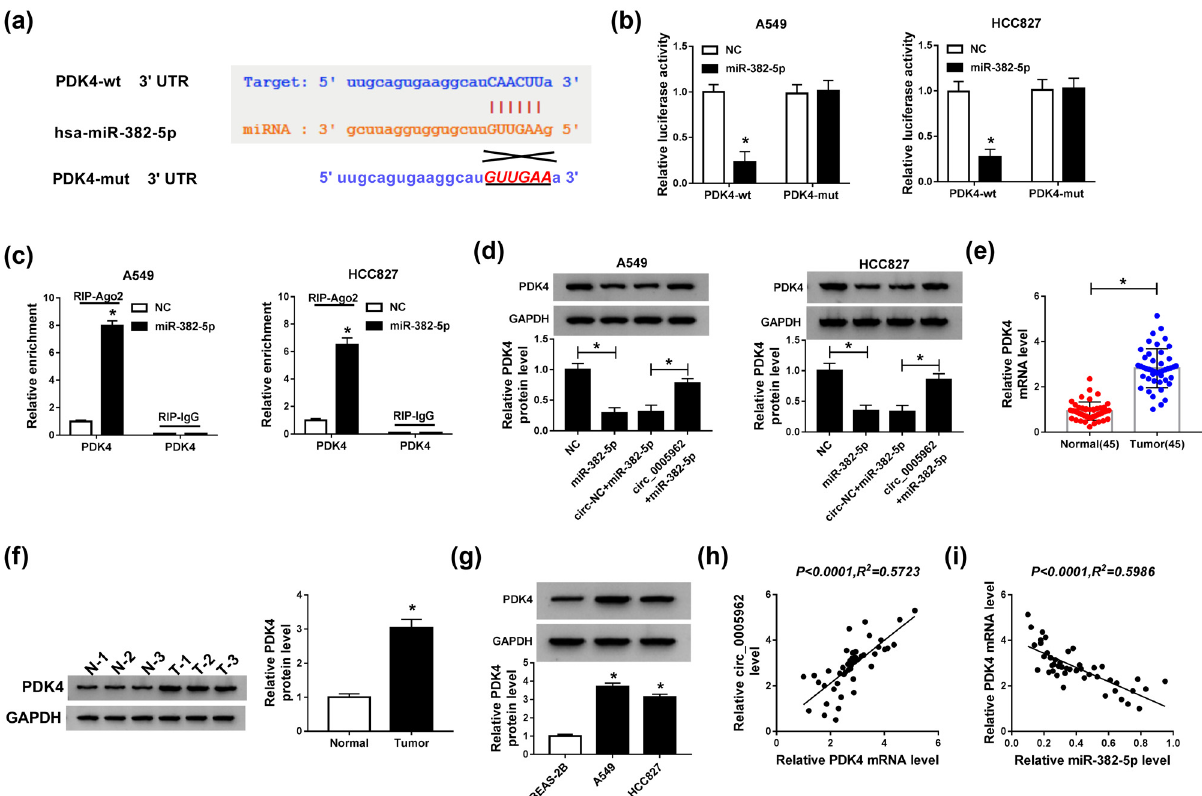
Figure 5: PDK4 was a target of miR - 382 - 5p. ( a ) The binding sites between PDK4 3 ′ UTR and miR - 382 - 5p were analyzed by online tool starbase. ( b ) The relationship between PDK4 and miR - 382 - 5p was veri fi ed by dual - luciferase reporter assay. ( c ) The relationship between PDK4 and miR - 382 - 5p was further con fi rmed by RIP assay. ( d ) The expression of PDK4 at the protein level in A549 and HCC827 cells transfected with miR - 382 - 5p or circ_0005962 + miR - 382 - 5p was detected by western blot. ( e and f ) The expression of PDK4 at mRNA and protein levels in NSCLC tissues was detected by qPCR and western blot. ( g ) The protein level of PDK4 in NSCLC cell lines was detected by western blot. ( h and i ) The correlation between PDK4 and circ_0005962 or miR - 382 - 5p was analyzed by Spearman ’ s correlation coe ffi cient. * P <